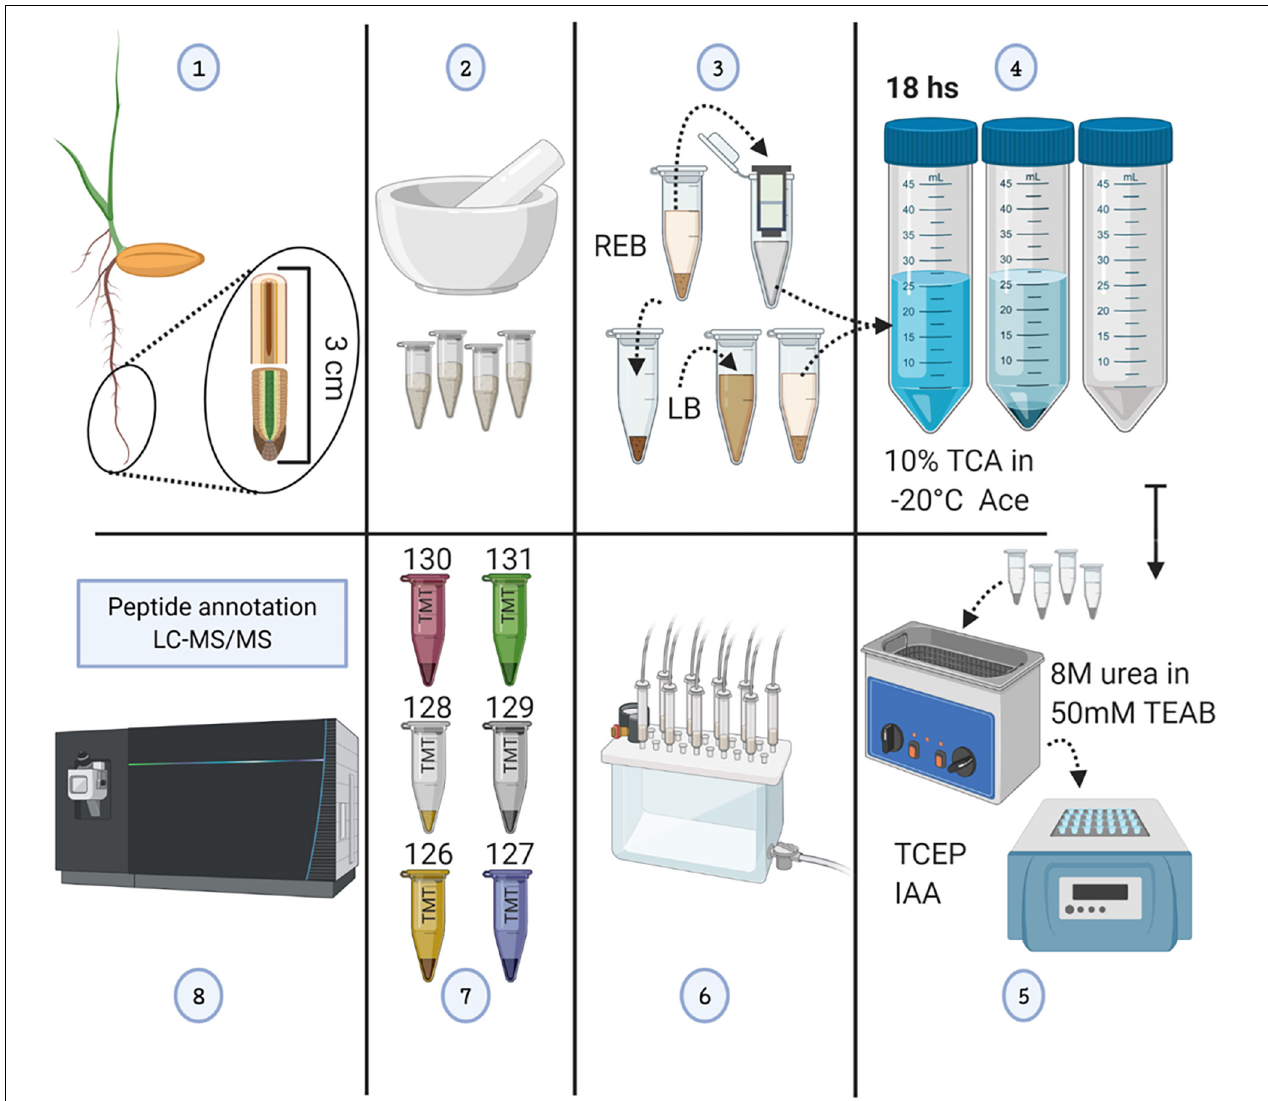
FIGURE 1 | Methodological workflow to achieve measurements of total protein content and individual protein abundances in barley root tips. See also Supplementary Figure 1 . (1) Harvesting of root tips from barley seedlings and division into two 1.5-cm segments. (2) Grinding of pooled tissue using liquid nitrogen, and mortar and pestle. (3) Proteome extraction; ribonucleoprotein complex enrichment using ribosome extraction buffer (REB) followed by detergent denaturation of the pellet using lysis buffer (LB). (4) Protein precipitation using -20 ◦ C cold 10% trichloroacetic acid (TCA) dissolved in acetone (Ace), subsequent centrifugation, and pellet washing. (5) Pellet solubilization, followed by protein reduction using tris(2-carboxyethyl)phosphine (TCEP; 10 mM of final concentration), alkylation with iodoacetamide (IAA; 55 mM of final concentration) in the dark, and overnight trypsin digestion. (6) Tryptic peptide cleaning using solid-phase extraction (SPE) cartridges. (7) Tandem mass tag (TMT) 6-plex labeling. (8) LC-MS/MS. The figure has been created with BioRender (https://biorender.com) and exported under a paid